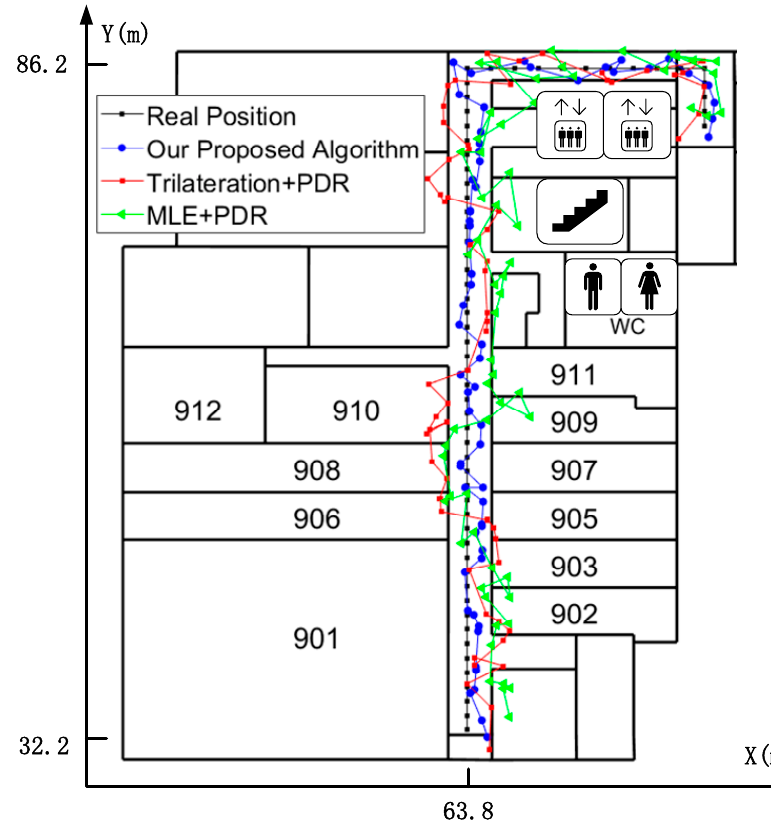
Figure 10. The localisation results of the three localisation algorithms.